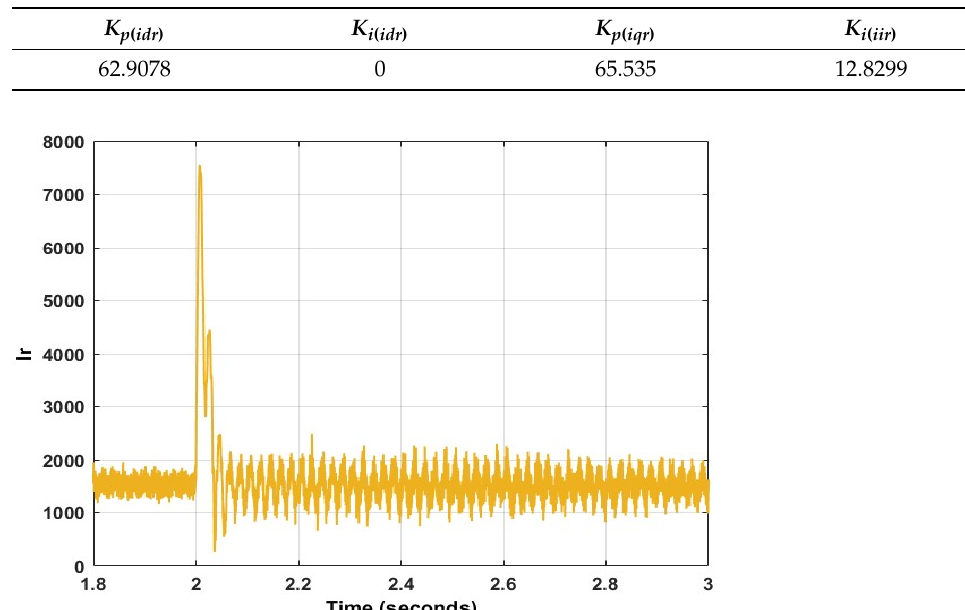
Table 5. PI controller gains for 80% dip.